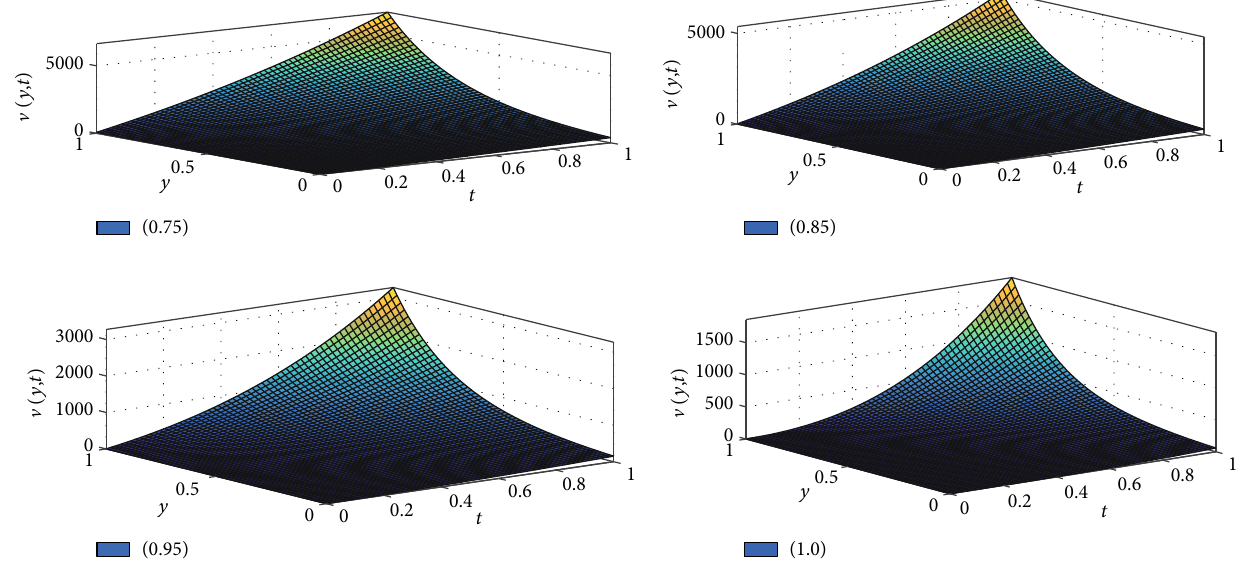
Figure 2: Surface plots of the resultant solution up to four terms at di ff erent values of γ for Example 2.